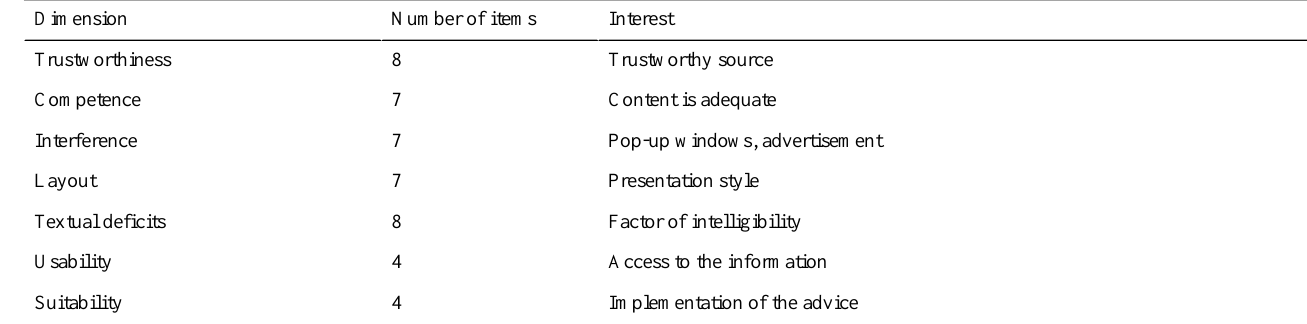
Table 1. The dimensions of the measure based on the observational study. InterestNumber of